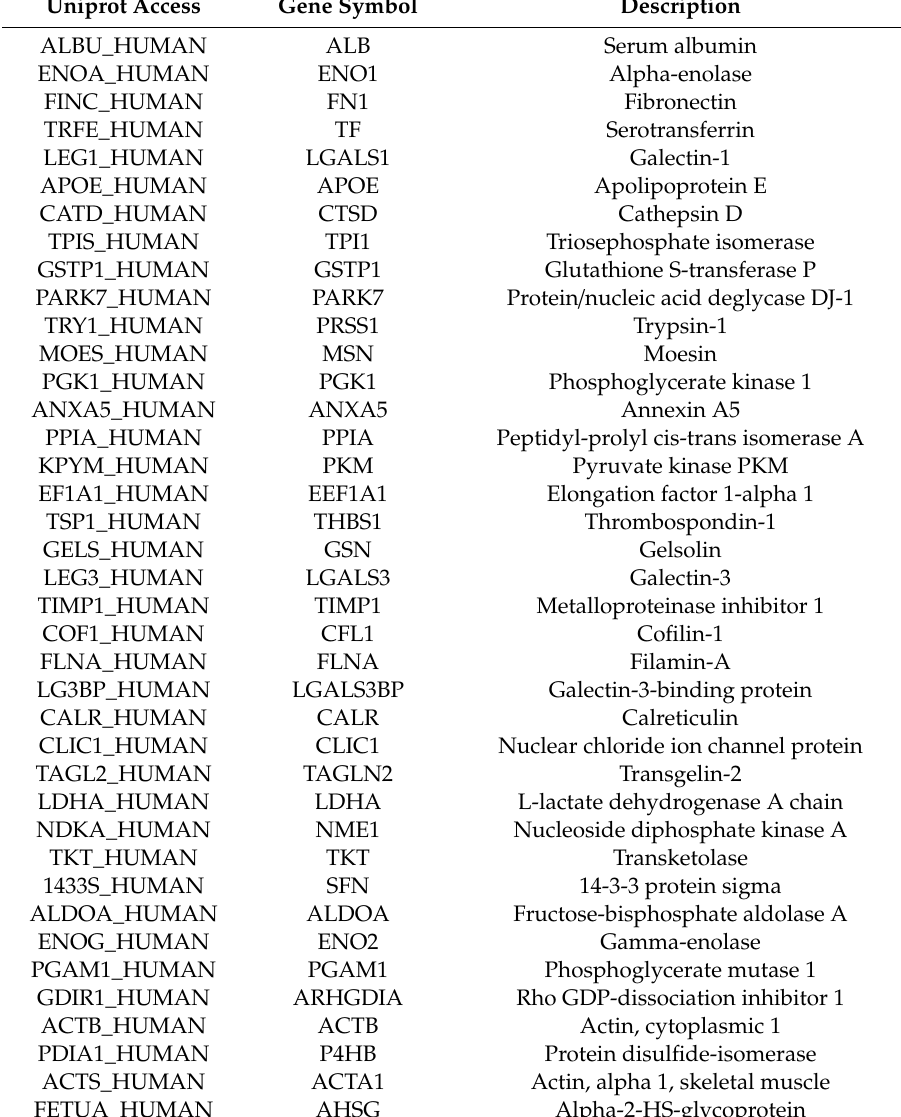
Table 3. Proteins shared between pancreatic cancer secretome and proteome